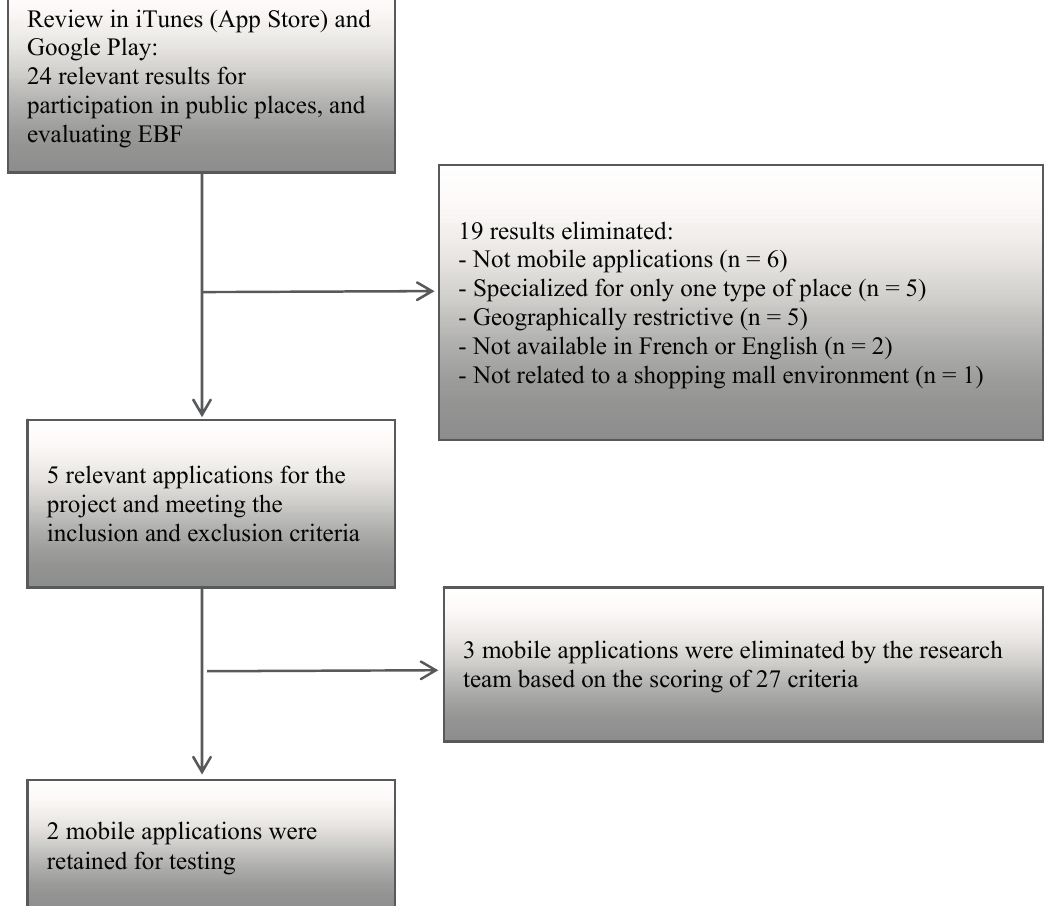
Figure 1 . Selection process of the mobile